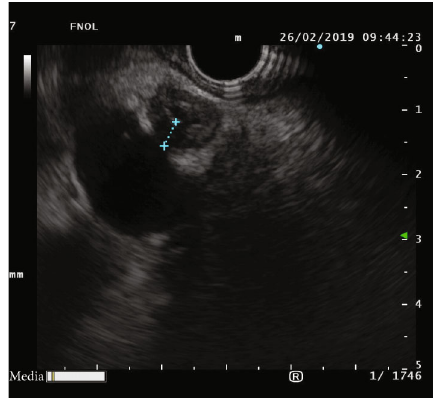
Figure 7: Linear endosonography view of a distal